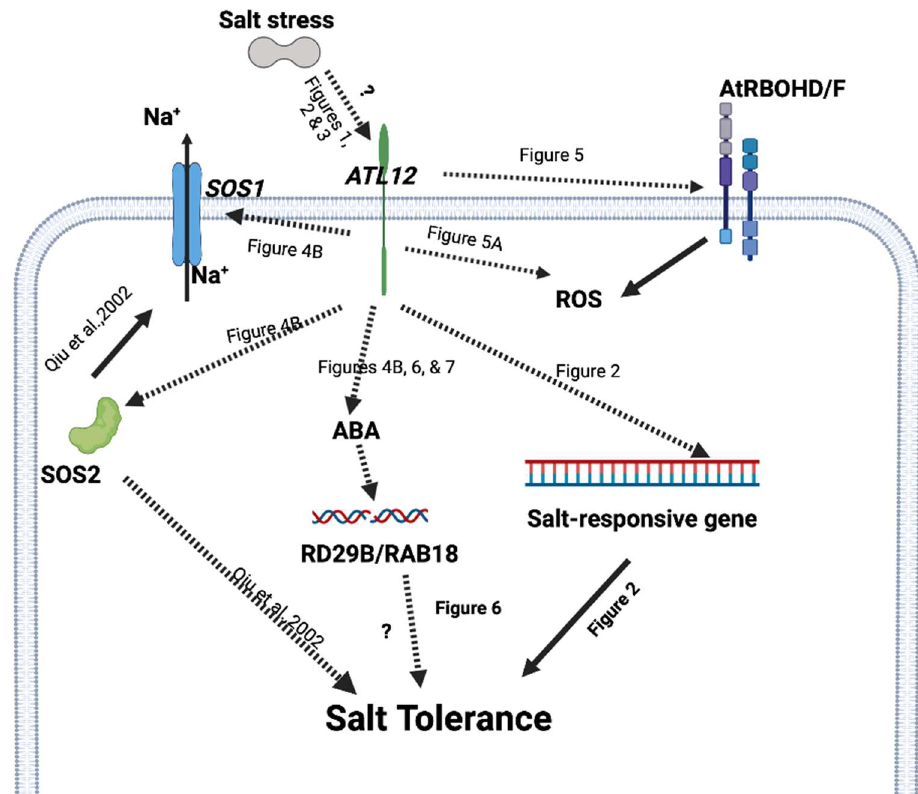
Figure 8. Proposed model for ATL12 ′s function in salt stress response. ATL12 is induced by salt stress and positively regulates salt tolerance in Arabidopsis seedlings (Figure 1, Figure 2 and Figure 3). Then ATL12 modulates salt stress responses via AtRBOHD/F -mediated ROS signaling (Figure 5), SOS1/2 signaling (Figure 4), and ABA-dependent signaling(Figure 6 and Figure 7) in Arabidopsis thaliana . A solid arrow indicates confirmed regulation or interaction. Dashed lines indicate our putative interactions with pathways or molecules that are confirmed by results. The question mark indicates further study is required.